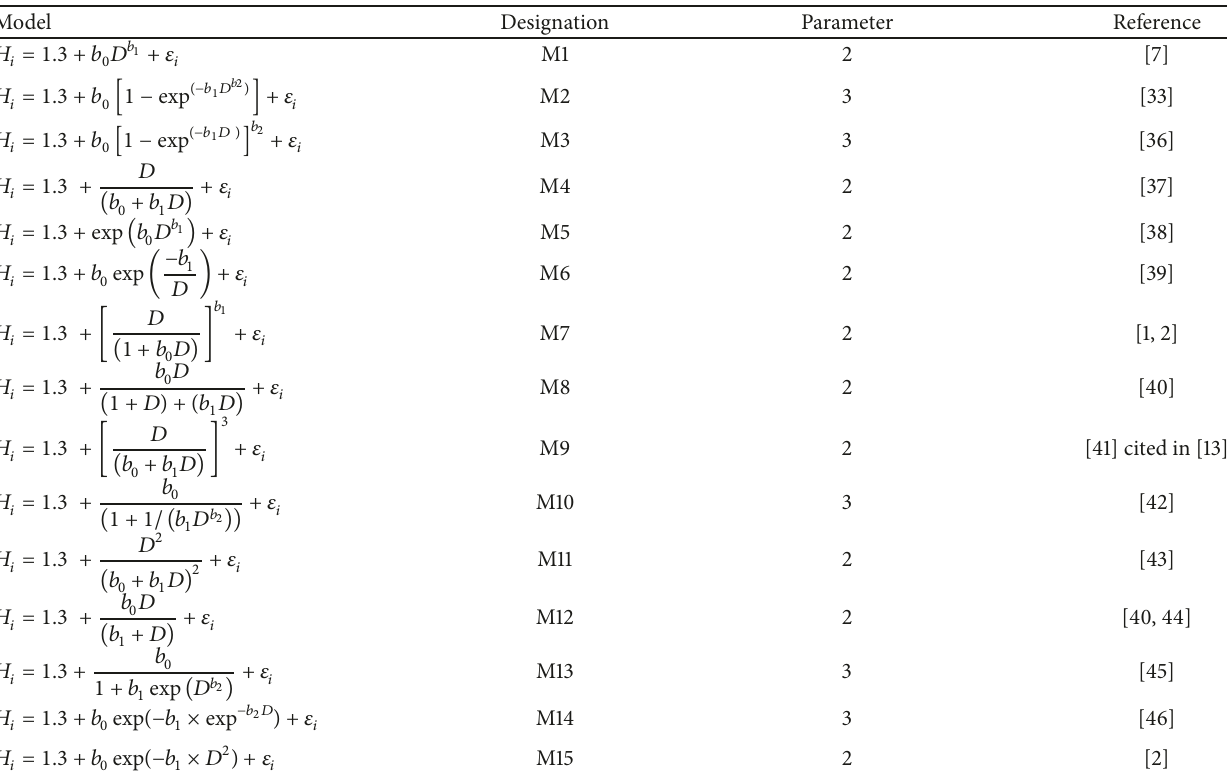
Table 2: Models selected for further evaluation, their designation, and parameters of the